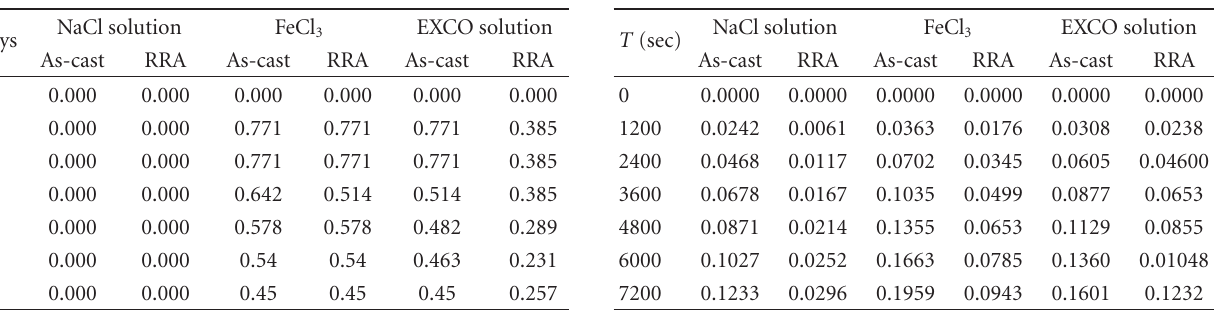
Table 6: Gravimetric corrosion rate (mm/yr) For the 1.81% Mg specimen.